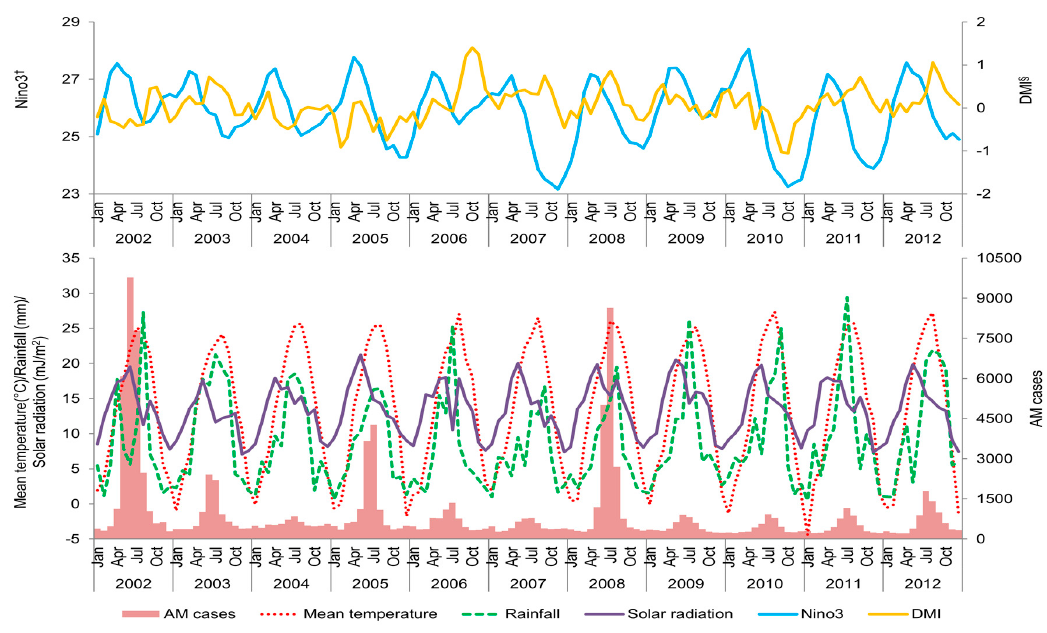
Figure 2. Monthly and yearly distributions of aseptic meningitis cases with meteorological factors in six metropolitan provinces of Korea, time period 2002–2012. The figure indicates monthly variation of aseptic meningitis cases with meteorological factors in the six metropolitan provinces of Korea over an 11-year period. The highest seasonal prevalence is found in the summer months. † monthly average of sea surface temperature in Nino3 region; § monthly average of Dipole Mode Index.